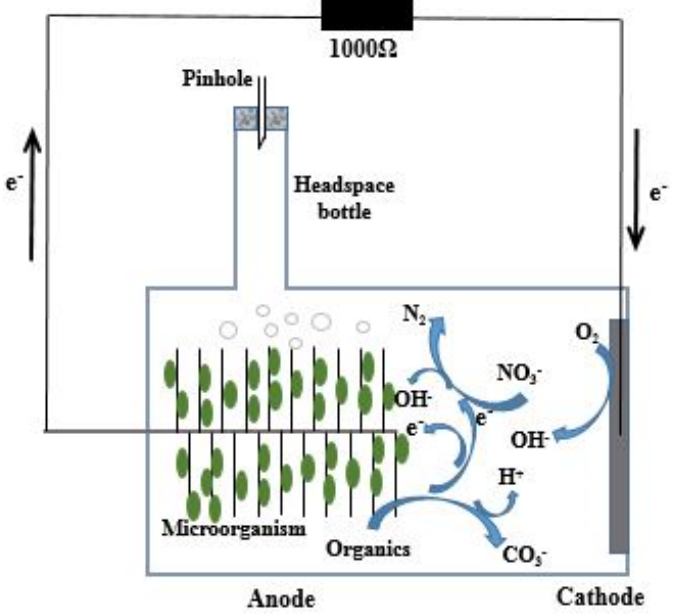
Figure 1. The schematic diagram of the microbial fuel cell reactor.